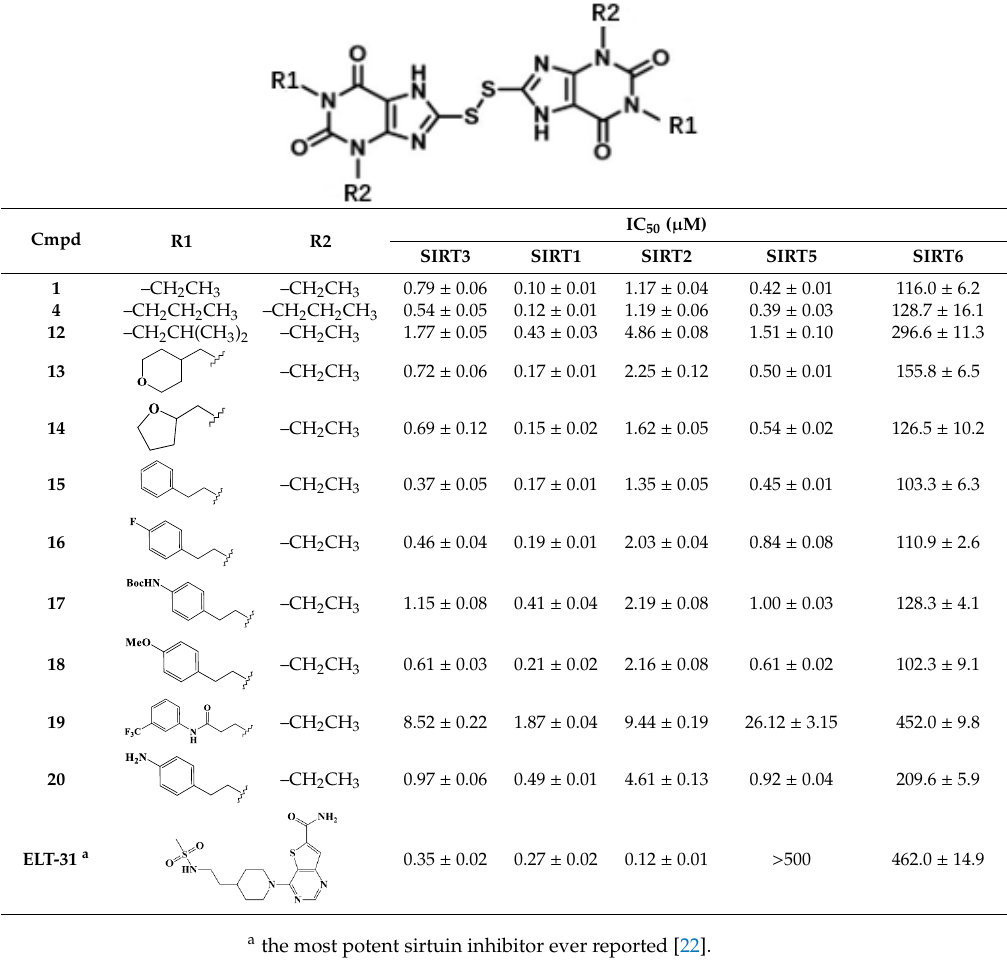
Table 1. Inhibitory activities of compound 1 and its derivatives for SIRT1/2/3/5/6.